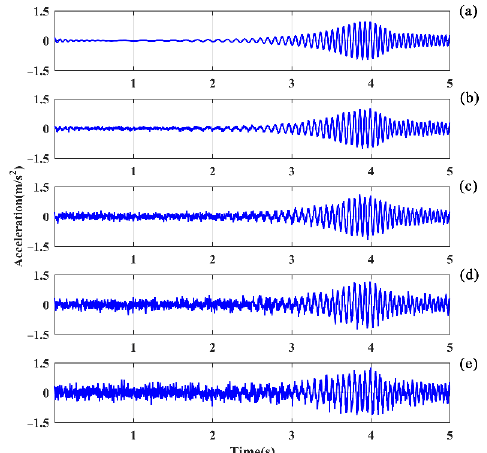
Figure 15. Clean signals and noisy signals in the time domain of beam 1 excited by SFE: ( a ) σ = 0; ( b ) σ = 0.05; ( c ) σ = 0.10; ( d ) σ = 0.15; ( e ) σ = 0.20.